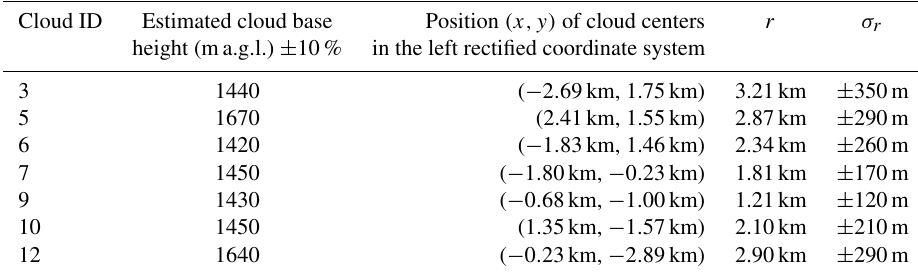
Table 4. Segmentation and geolocalization results.